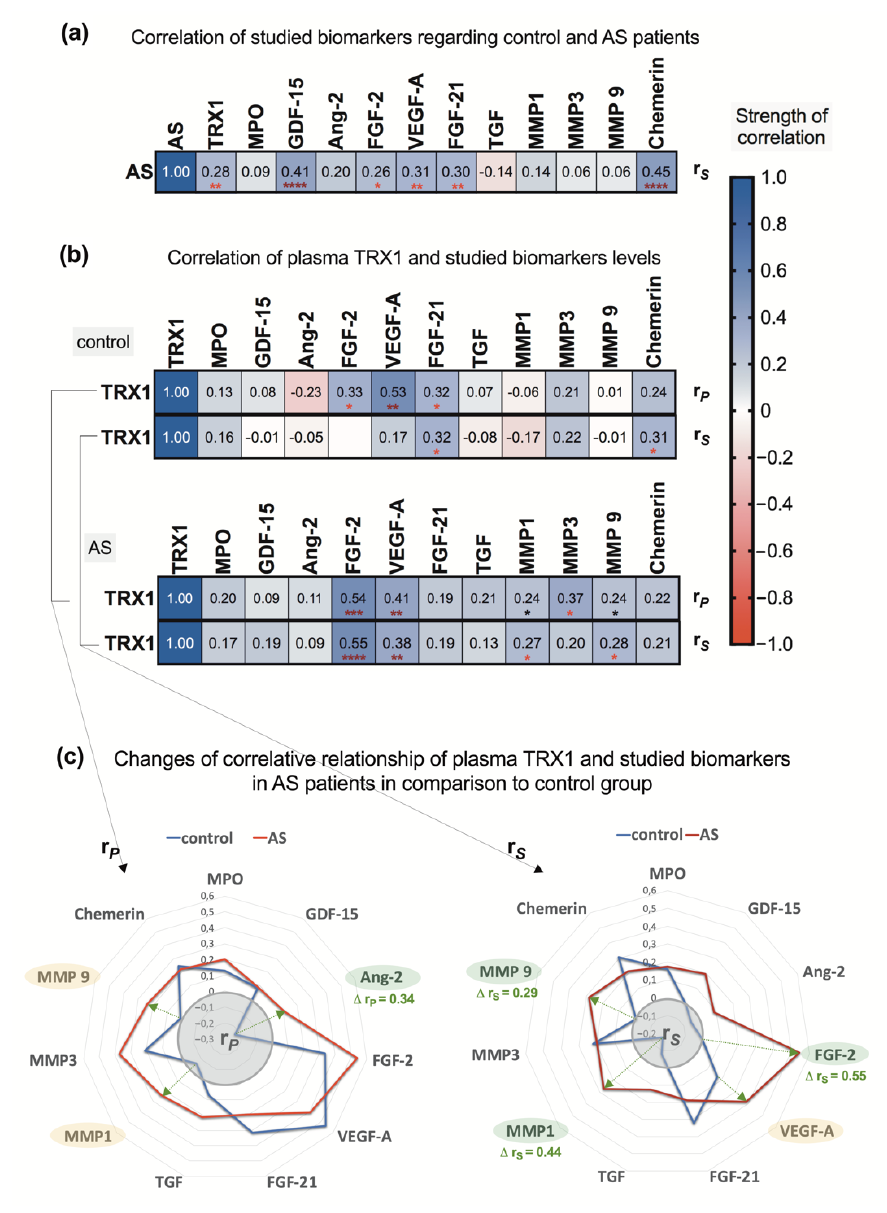
Figure 6. Correlative associations of the studied biomarkers: ( a ) regarding control and AS patients; ( b ) regarding TRX1 and biomarkers in control and AS patients; ( c ) comparative changes in correlative relation and respective biomarkers; r P and r S : correlation coefficients (Pearson’s and Spearman’s, respective); green arrows show the most pronounced difference between correlation coefficients of the respective biomarker, that was calculated by expression Δ r = r max − r min ; closeness of associative relations is characterized by p -value—* 0.08 < p > 0.05, * p < 0.05, ** p < 0.01, *** p < 0.001, **** p < 0.0001.